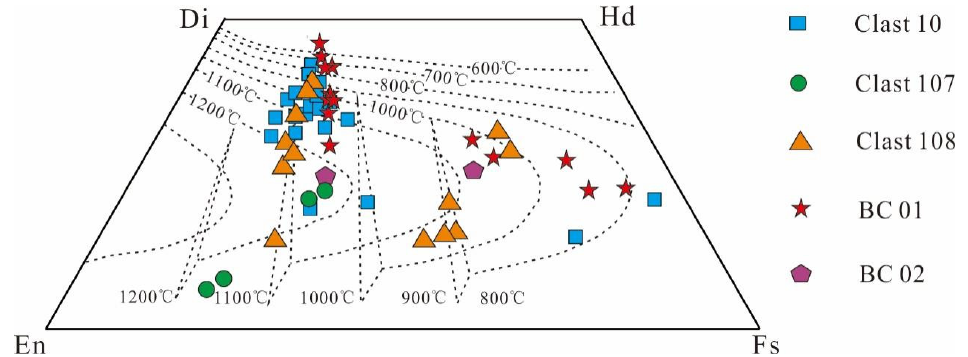
Figure 6. Composition of pyroxene in second types of CIM clasts and basaltic clasts. Pyroxene geothermometer after